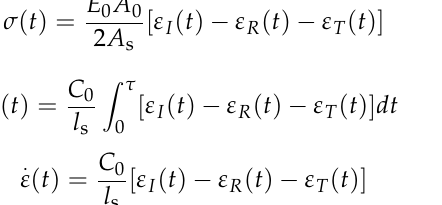
Figure 5. Typical voltage-time waveform.